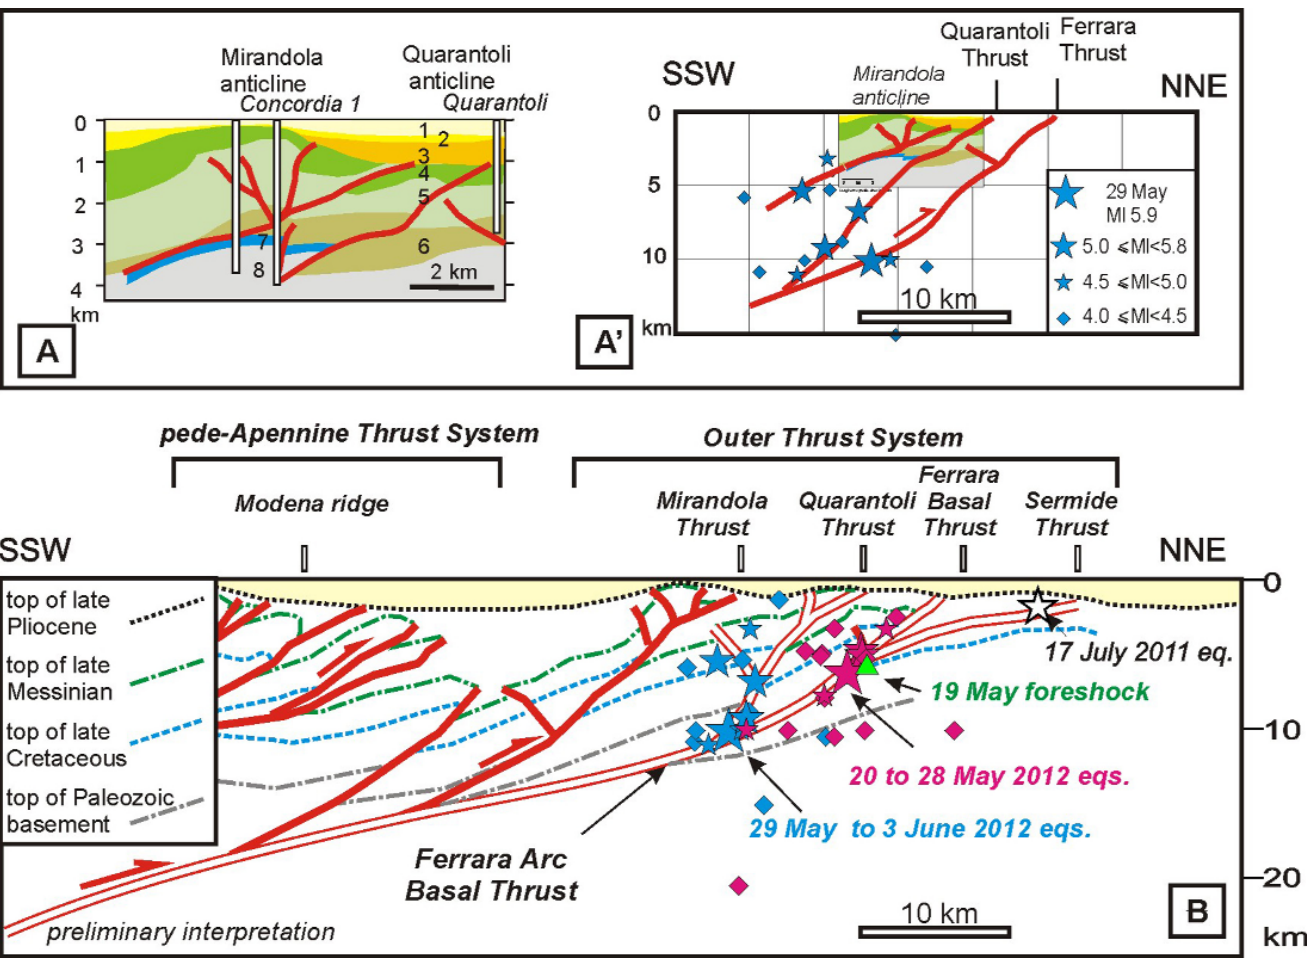
Figure 3. Interpretative sections across the Ferrara Arc (traces of sections A and A' in Figure 2, and trace of section B in Figure 1). (A) Geological sec- tion across the Mirandola anticline, from Martelli and Molinari [2008]. 1, Continental Quaternary; 2, Marine Quaternary; 3, Middle Pliocene; 4, Early Pliocene; 5, Colombacci Fm. (Late Messinian); 6, Marne di Gallare (Late Eocene-Messinian); 7, Early Cretaceous-Middle Eocene; 8, Noriglio limestone (Early Jurassic). (A') Schematic section across the Ferrara and Mirandola thrusts, compared with the May 29 to June 12, 2012, earthquake distribution ≥ 4.0). (B) Regional cross-section along the line ENI, App. East-1 [modified from Toscani et al. 2009] compared with the May 29 to June 12, 2012, (M L ≥ earthquake distribution (M L